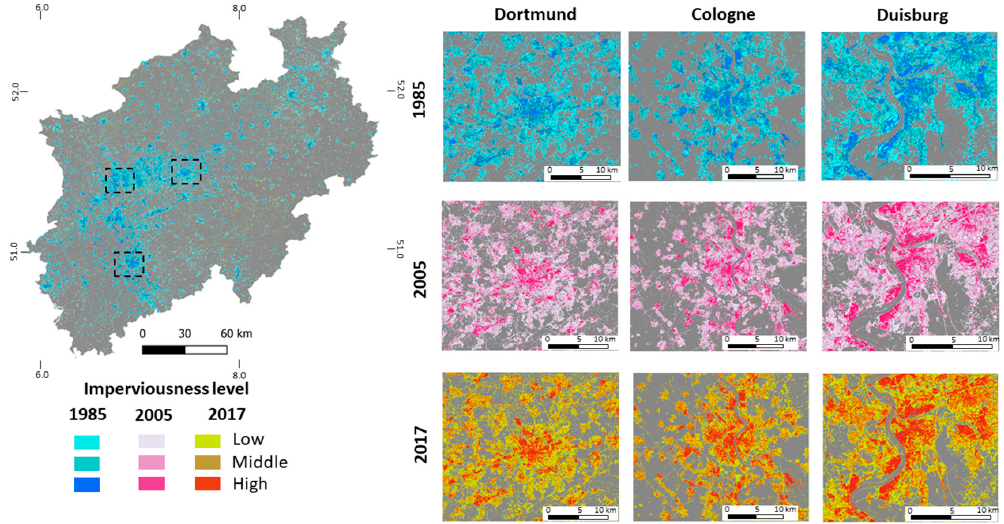
Figure 9. Changes in imperviousness level during the 32 years in NRW and for three selected cities, namely Dortmund, Cologne, and Duisburg.